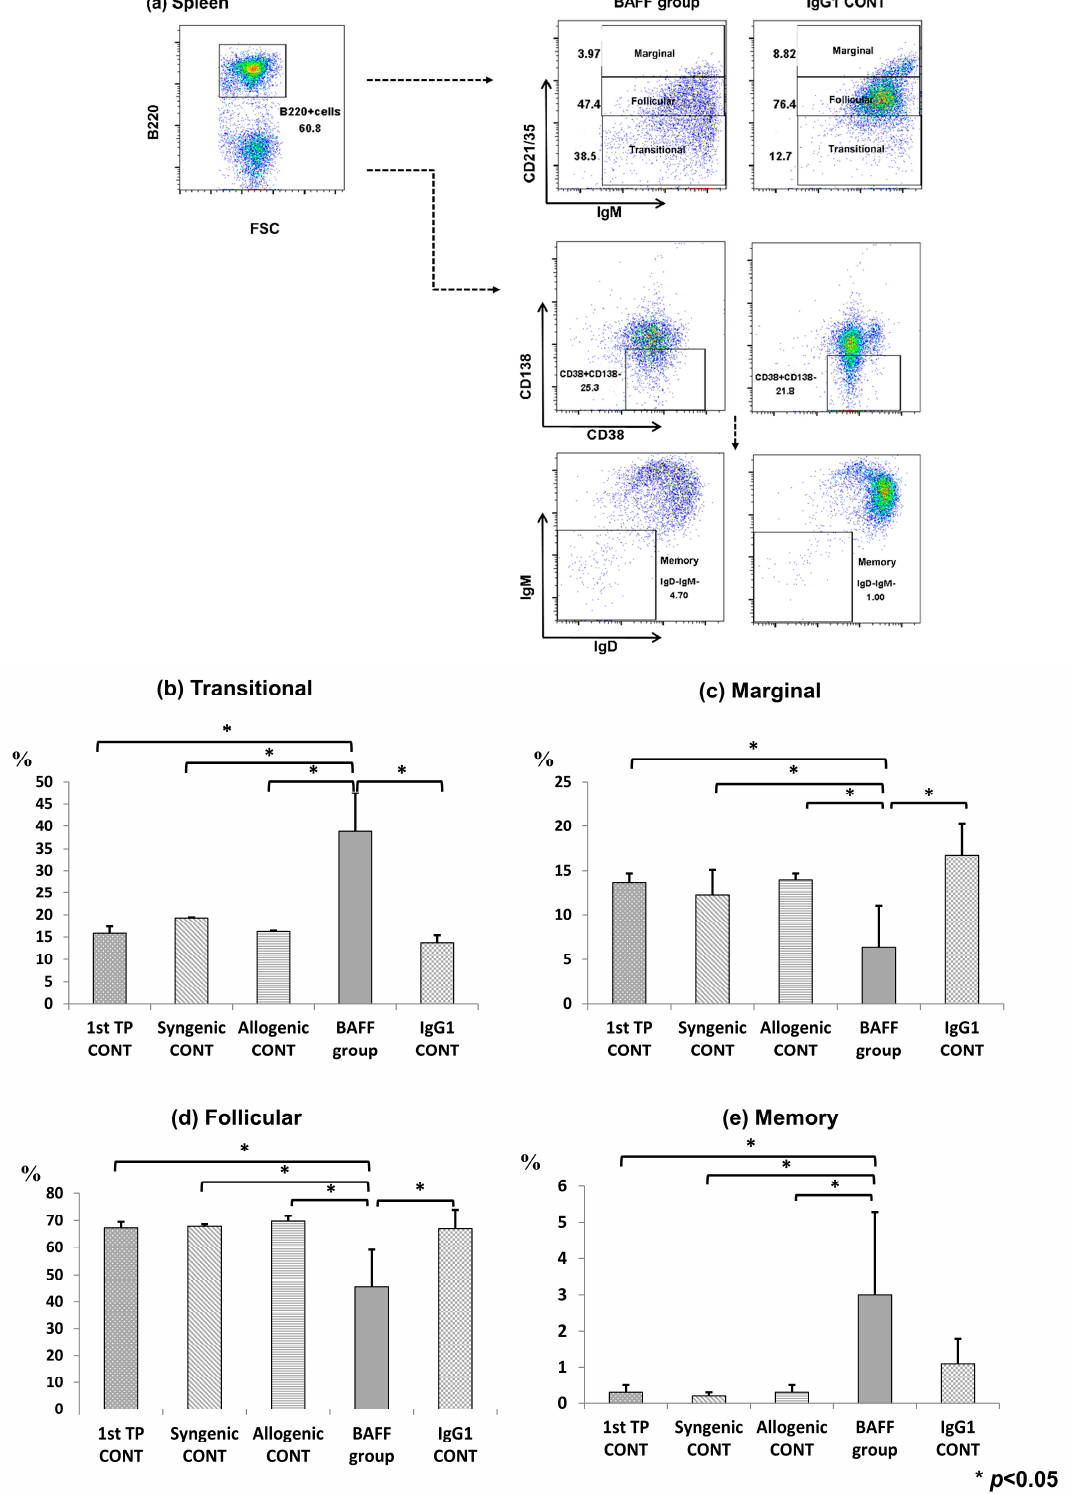
Figure 3. B cell population at week 9 (4 weeks after second transplantation) in the recipient spleen analyzed using flow cytometry. ( a ) Gating strategy, ( b ) fractions of B220+CD21/CD35loIgM+ transitional B cells, ( c ) B220+CD21/CD35hiIgM+ marginal B cells, ( d ) B220+ CD21/CD35+IgM+ follicular B cells, and ( e ) B220+CD138-CD38+IgM-IgD- memory B cells. Error bars represent 2 standard errors (SE).